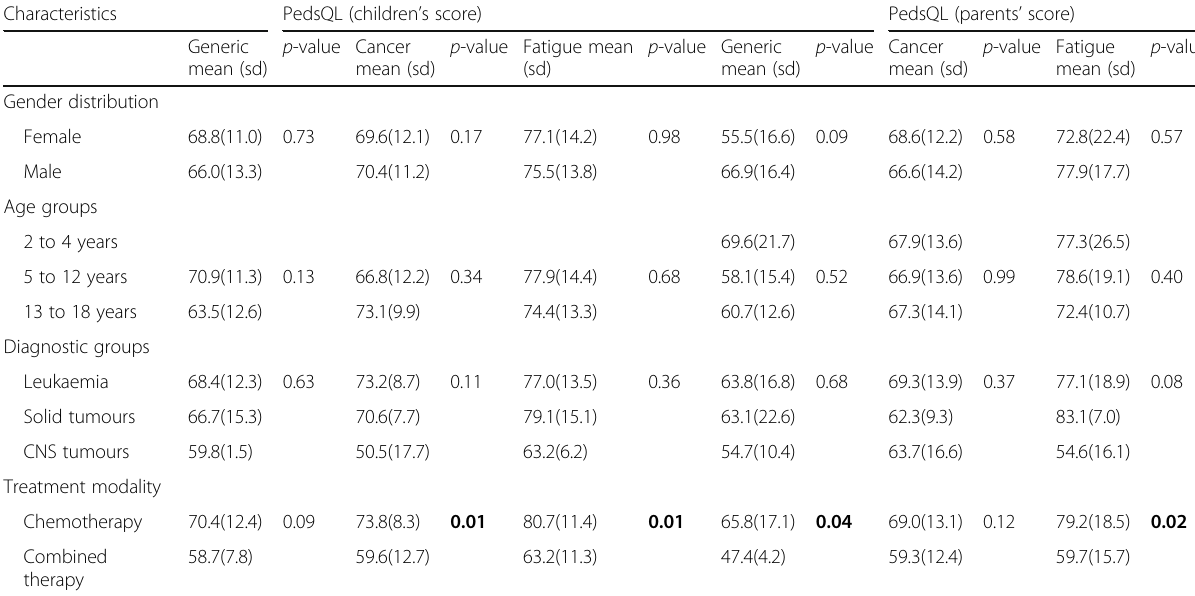
Table 4 PedsQL ™ , children ’ s and parents ’ /proxy- self-reports within Argentina Characteristics